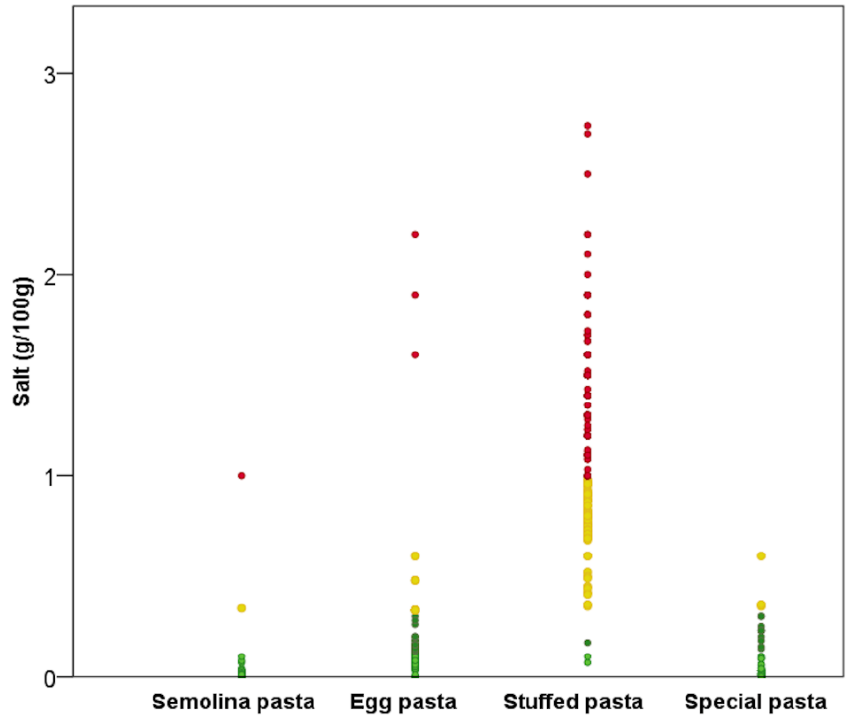
Figure 1. Salt content of the pasta products. Coloured dots refer to the classification for salt content by Council Regulation (EC) No 1924/2006 [13]: light green = very low salt content (<0.12 g/100 g); green = low salt content (<0.3 g/100 g); yellow = medium salt content (<1 g/100 g); red = high salt content ( ≥ 1 g/100